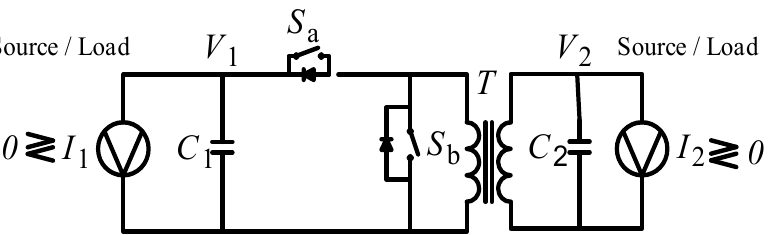
Figure 4. Main circuit topology: isolated bi-directional DC–DC converter based DCSOP.